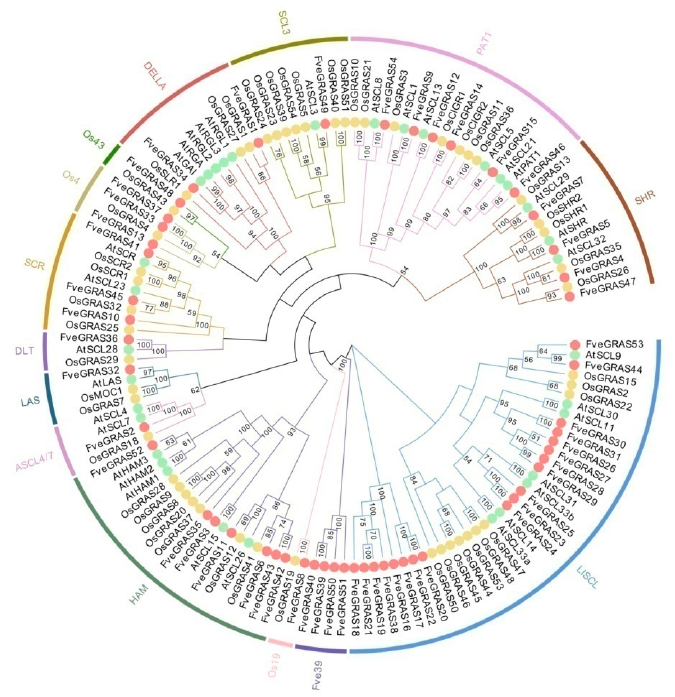
Figure 1. Phylogenetic relationship of GRAS proteins in Arabidopsis thaliana , rice and woodland strawberry. 33, 50 and 54 GRAS proteins from Arabidopsis thaliana , rice and woodland strawberry were selected to construct phylogenetic tree using MEGA6.0 by the NJ (neighbor-joining) method with the bootstrap test replicated 1000 times. GRAS proteins from Arabidopsis thaliana , rice and woodland strawberry are represented by green, yellow and red dots.